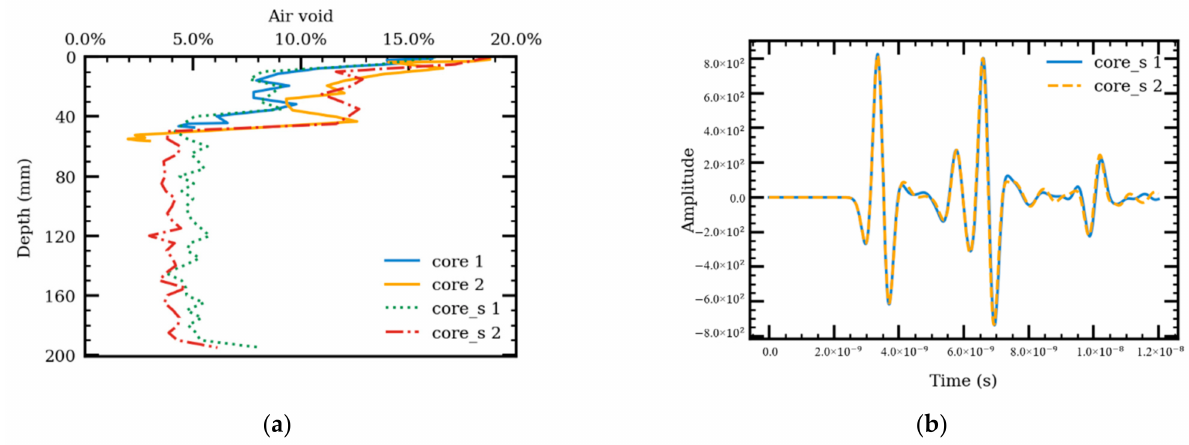
Figure 11. Air void distribution along the depth ( a ) and corresponding received signals from the simulation models ( b